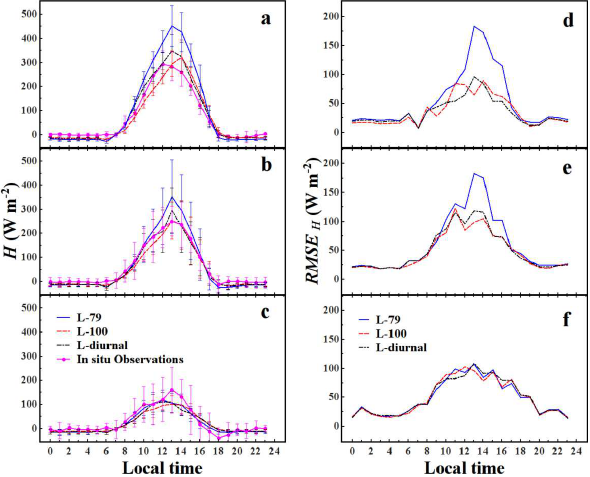
Figure 2. Left panel: comparison of the mean diurnal variations in Fig. 2. Left panel: Comparison of the mean diurnal variations in H obtained through the L-79, L-100 and H obtained through the L-79, L-100 and L-diurnal configurations L-diurnal configurations together with the concurrent in situ observations for a clear-sky, b cloudy but non- together with the concurrent in situ observations for (a) clear-sky, precipitating, and c rainy days. Right panel: Diurnal variations in the RMSE associated with the L-79, L-100 (b) cloudy but non-precipitating, and (c) rainy days. Right panel: and L-diurnal configurations corresponding to d clear-sky, e cloudy but non-precipitating, and f rainy days. Verticalerrorbarsrepresentthestandarddeviationsinthecorresponding measurements. diurnal variations in the RMSE associated with the L-79, L-100 and L-diurnal configurations corresponding to (d) clear-sky, (e) cloudy but non-precipitating, and (f) rainy days. Vertical error bars repre- sent the standard deviations in the corresponding